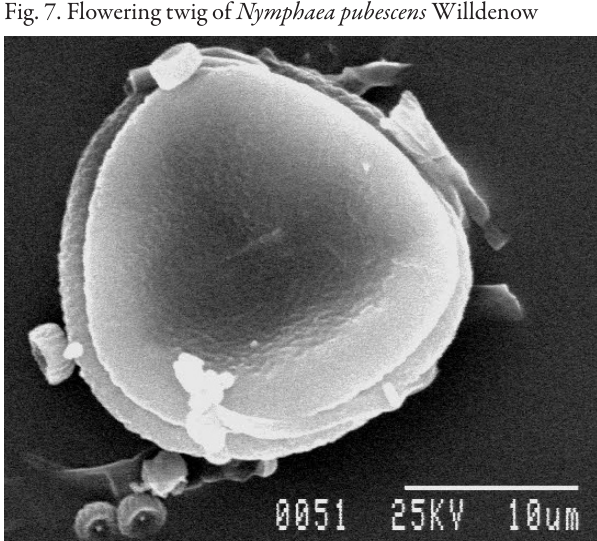
Fig. 8. X3000, showing monocolpate ellipsoidal pollens of Nymphaea pubescens Willdenow